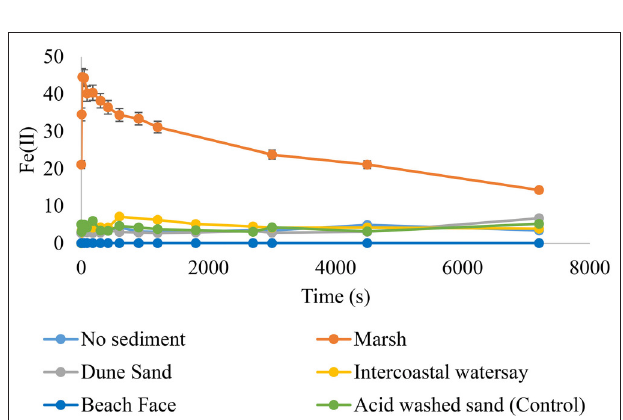
FIGURE 4 | Fe(II) evolution after HS − addition. The introduction of HS − (aq) to aerated sediment suspensions (1.00 wt%) seawater resulted in the formation of Ferrozine-responsive Fe(II). The highest yields of Fe(II) were obtained from sediments with high concentrations of hydrous ferric oxides. Results from pH 8.25